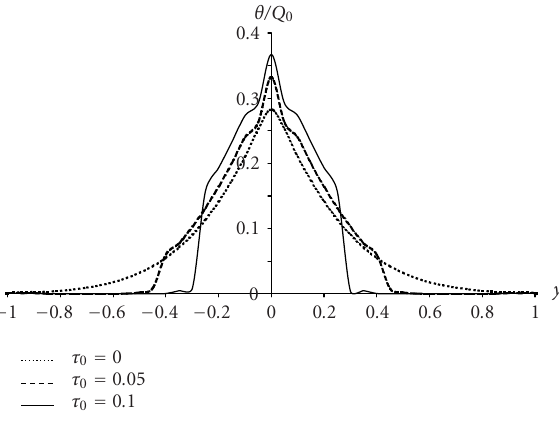
Figure 7.2. The temperature distribution for di ff erent values of τ 0 for the whole space problem.